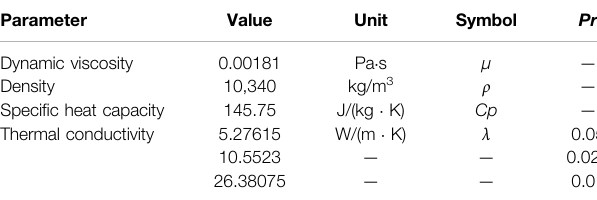
TABLE 3 | Physical properties for Pr = 0.01, 0.025, and